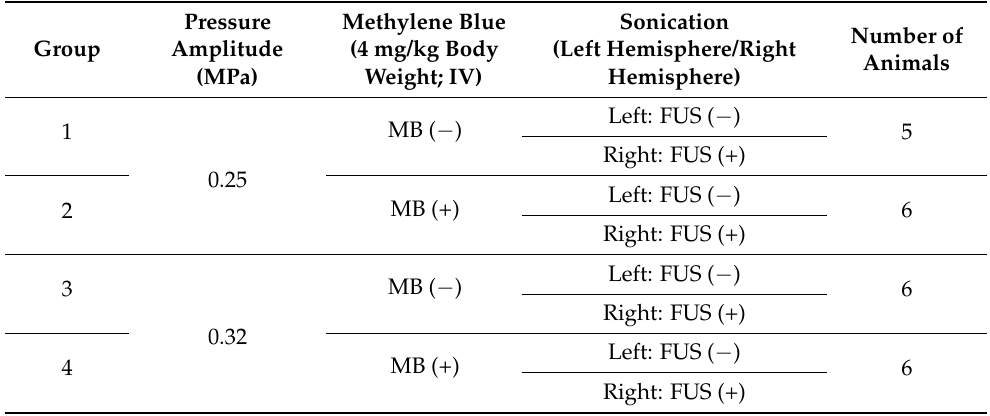
Table 1. Summary of the experimental